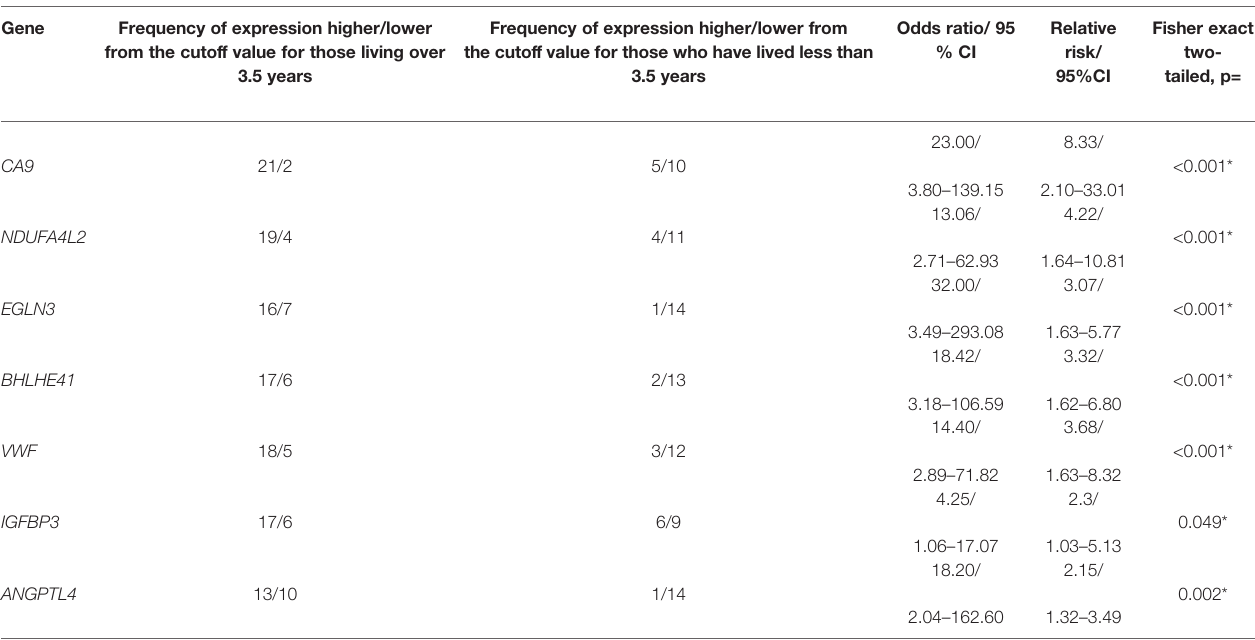
TABLE 7 | The frequencies of gene expression levels relative to the cutoff value among ccRCC patients living more and less than 3.5 years and characteristics of the association of gene expression with the life duration. Gene Frequency of expression higher/lower from the cutoff value for those living